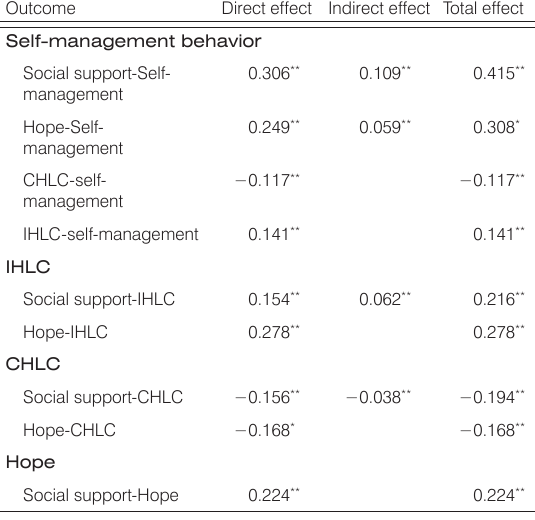
Table 4. Direct and indirect